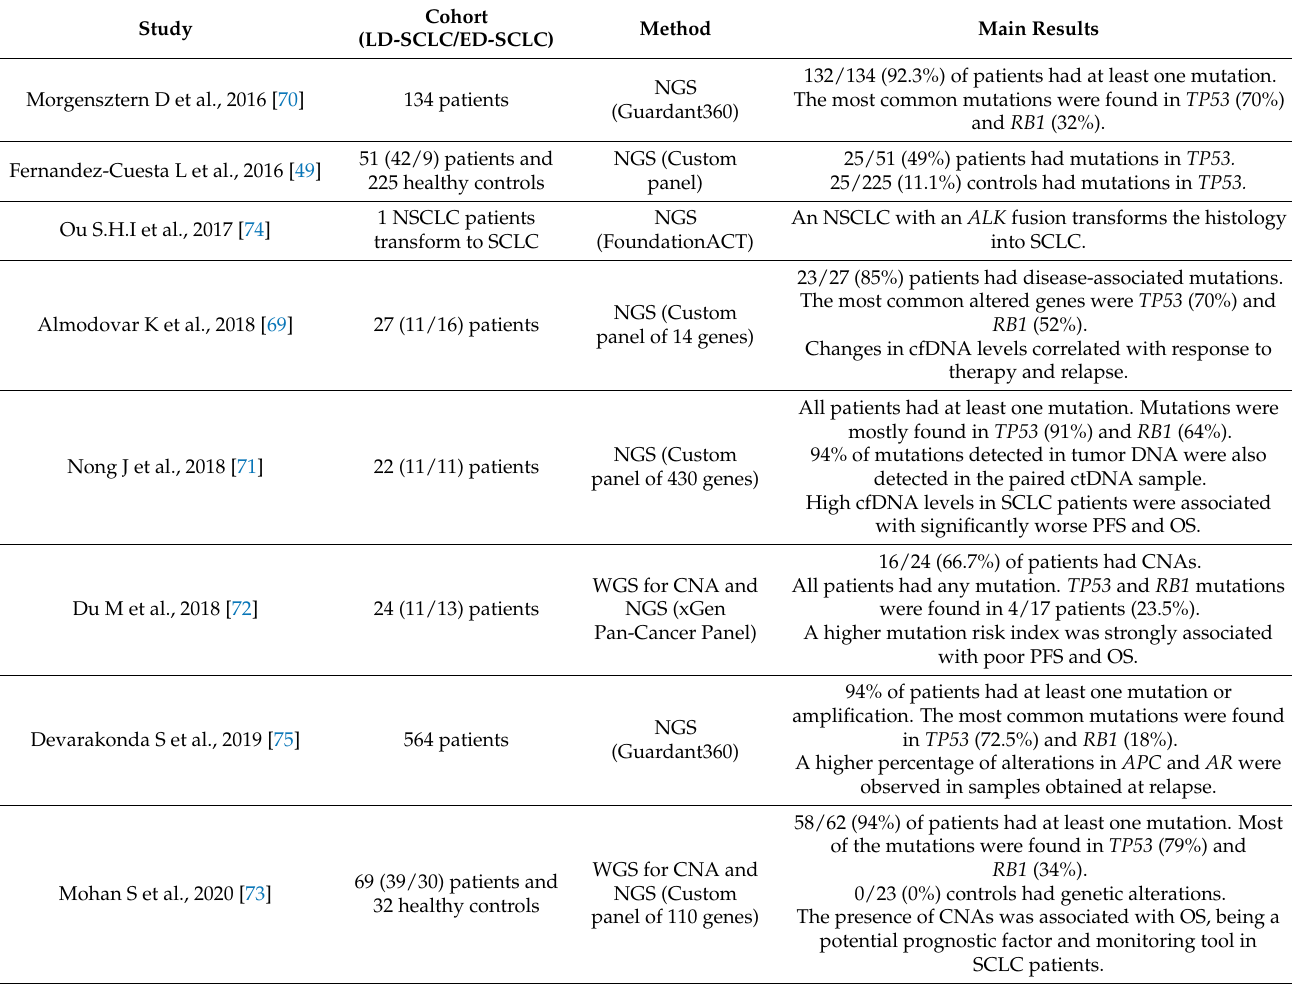
Table 1. Summary of cfDNA studies in